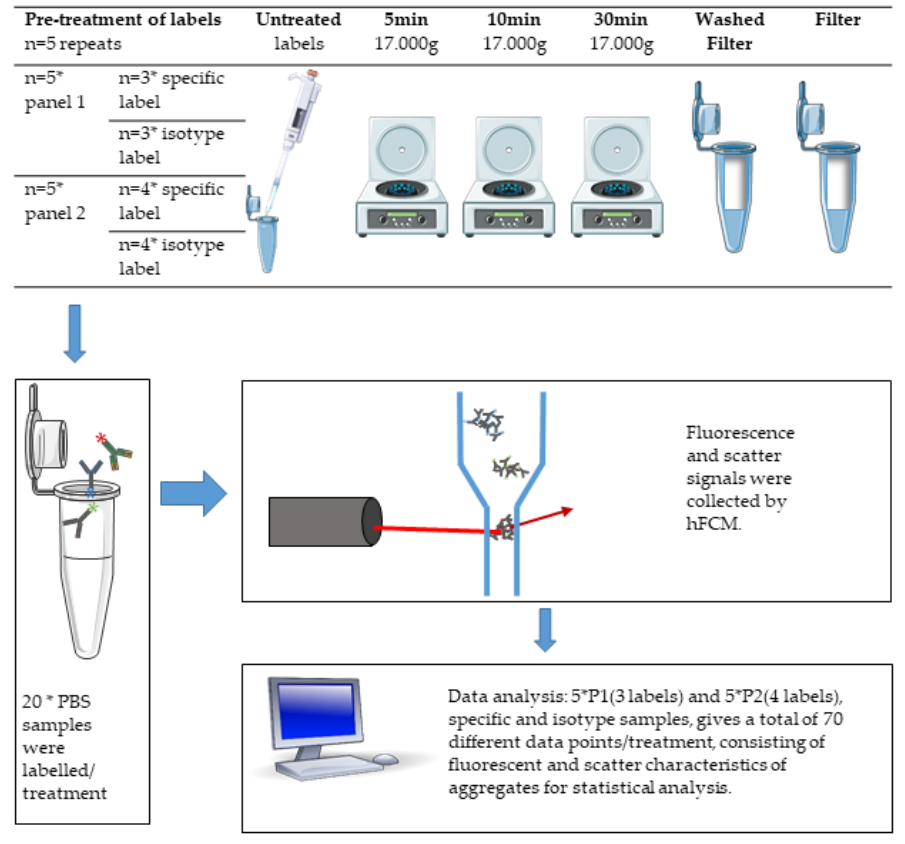
Figure 1. Flowchart of pre-treatment, labeling, high-resolution flow cytometer (hFCM) analysis, and data analysis.